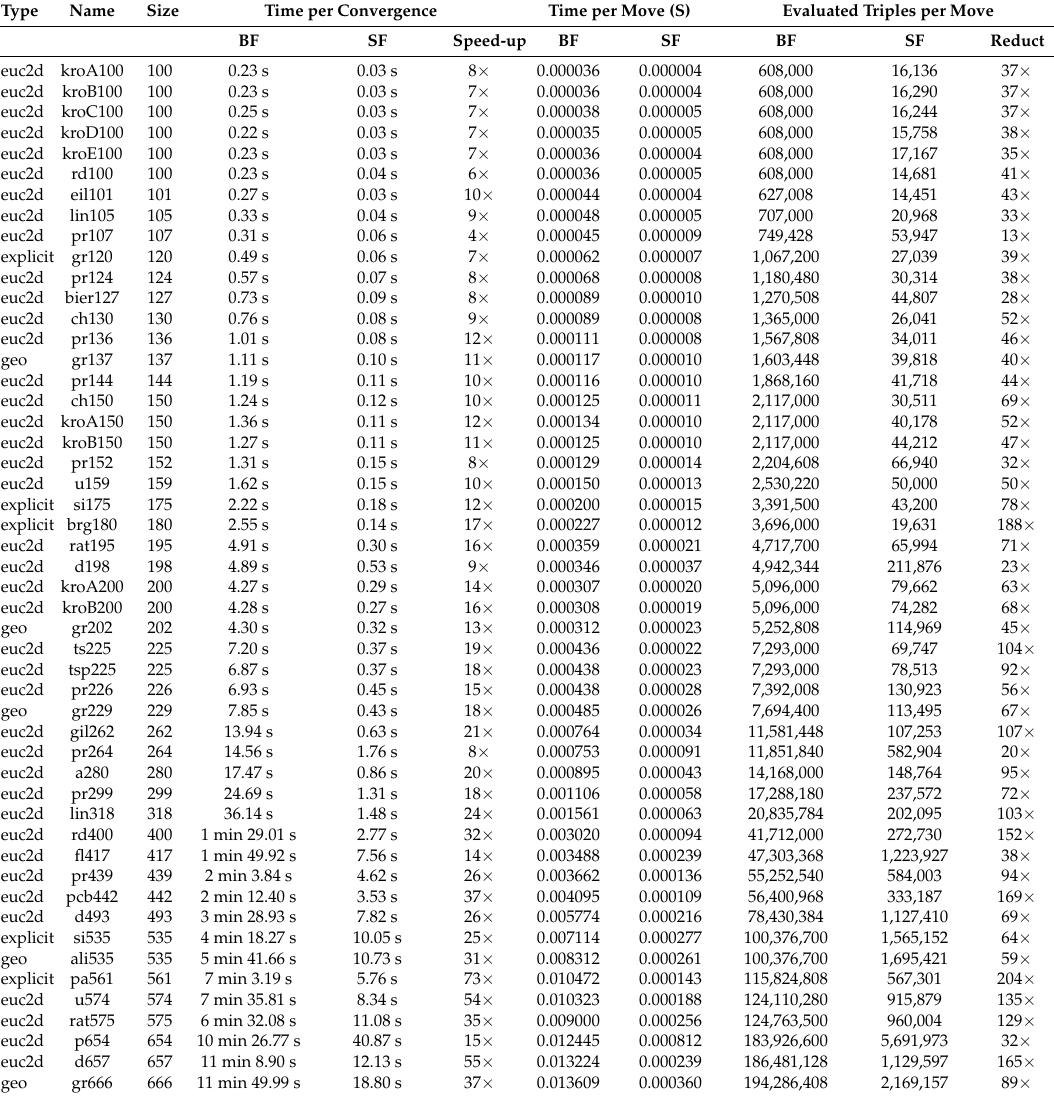
Table 6. Average times needed to perform convergences to a local optimum tour starting from 100 different random tours. Instances are taken from TSPLIB. BruteForce running times are estimated for sizes larger than